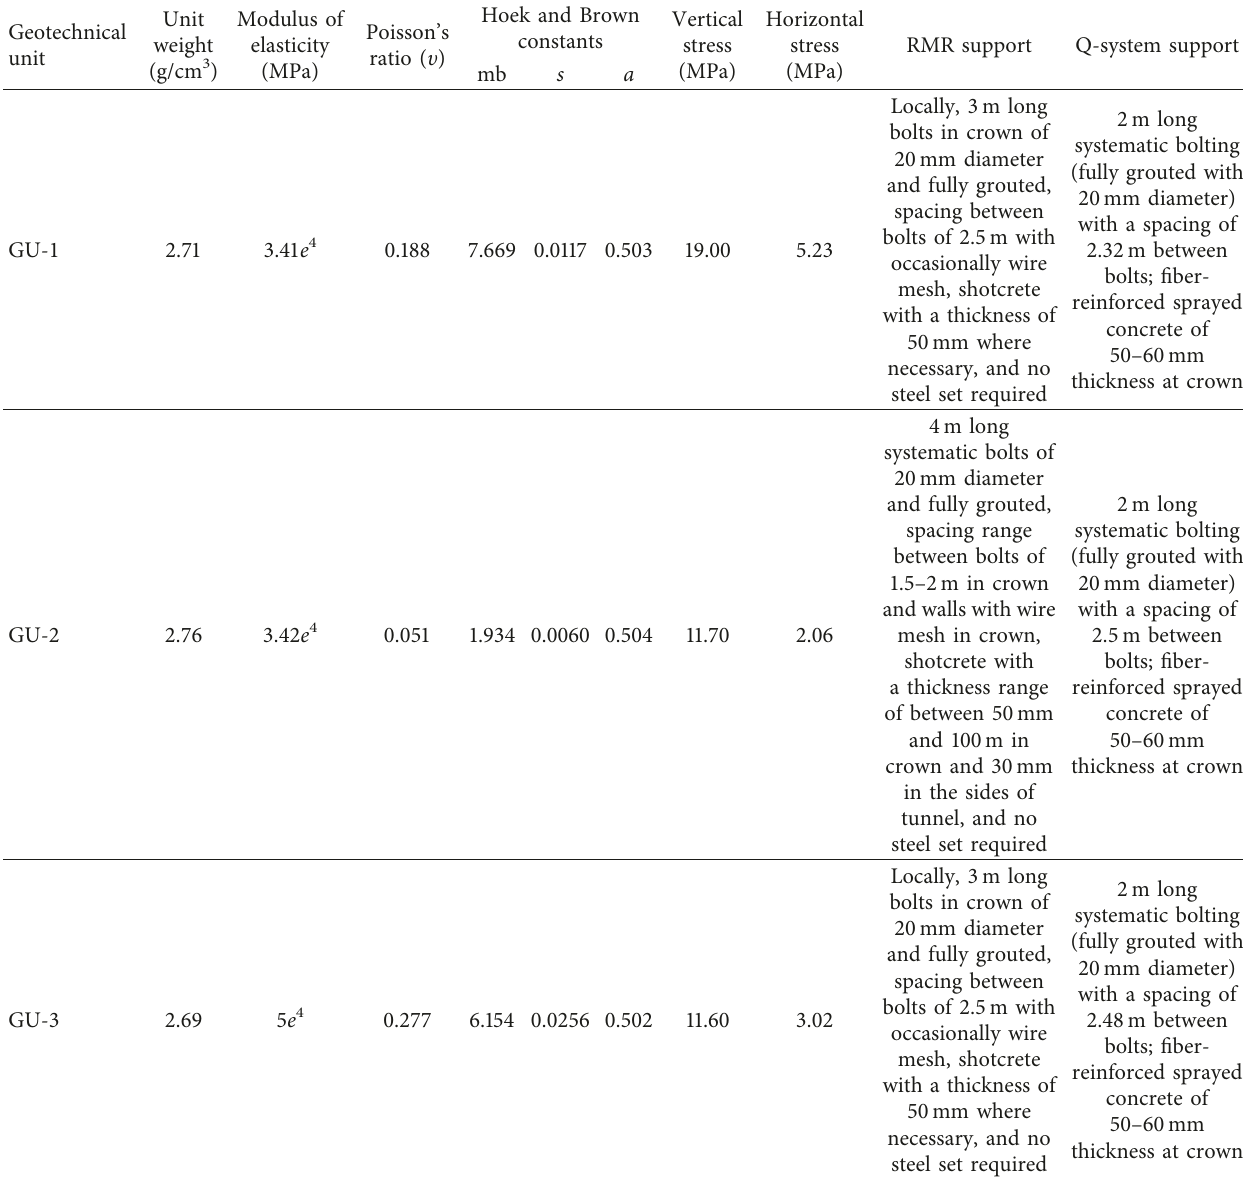
Table 2: Parameters for numerical